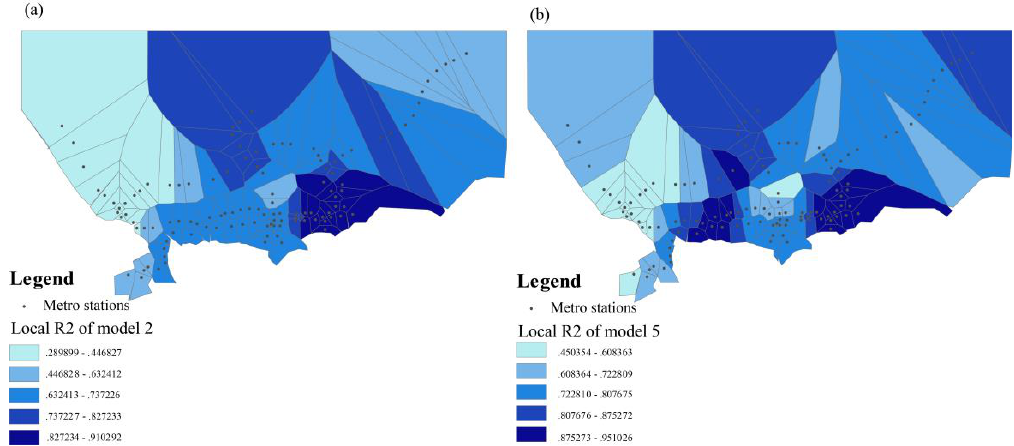
Figure 6. Spatial distribution of the local R-squared values of Model 2 and Model 5. ( a ) Local R-squared values’ distribution of Model 2 (average weekday). ( b ) Local R-squared values’ distribution of Model 5 (nonrush hour).